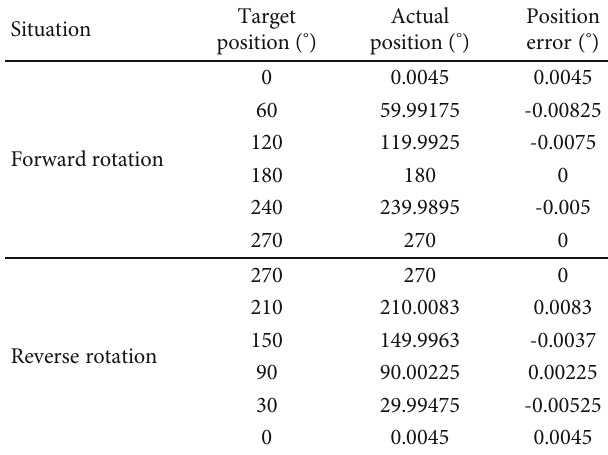
Table 1: Transitions selected for thermometry.